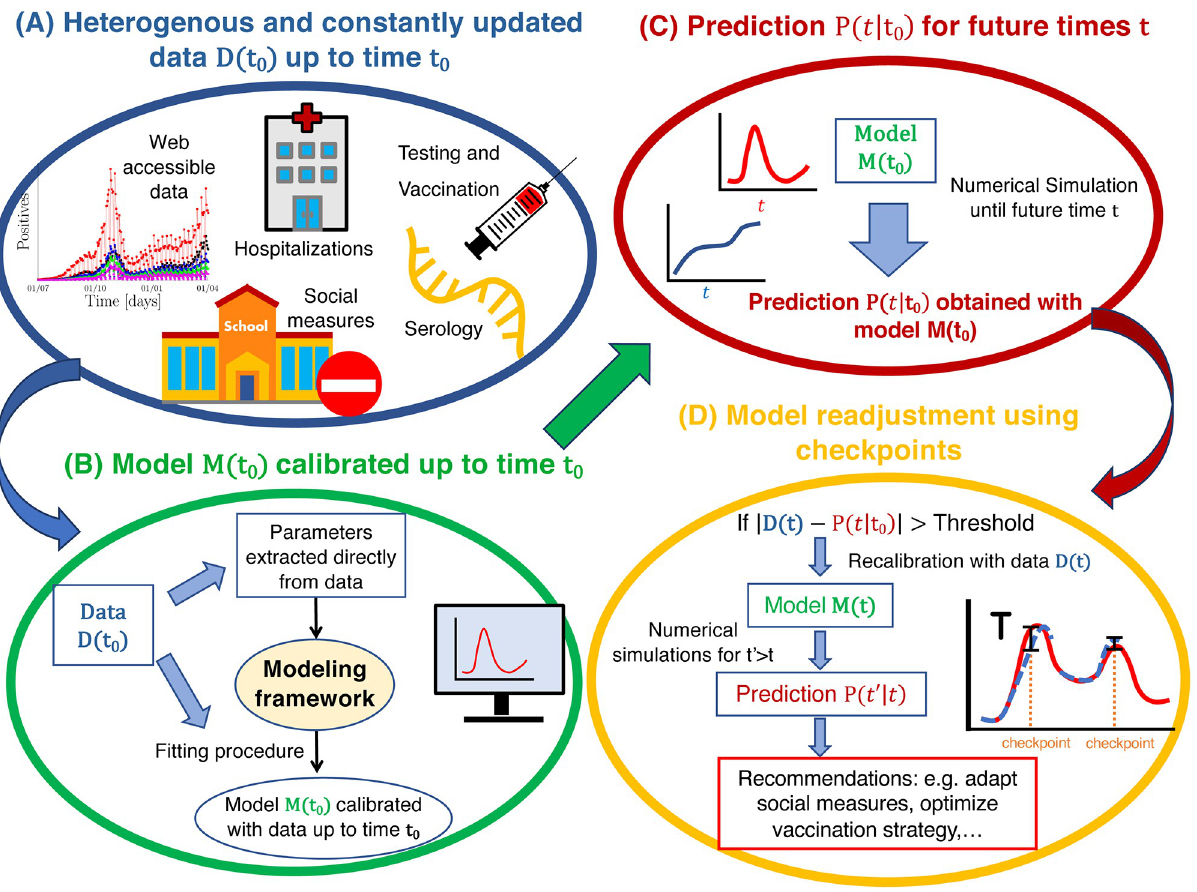
Fig 2. Automated data-driven checkpoint procedure to control a pandemic evolution. (A) A variety of constantly updated data is used to calibrate the model. (B) The model M ( t 0 ) is calibrated with data D ( t 0 ) up to time t 0 . (C) The calibrated model M ( t 0 ) is used to predict the pandemic and hospitalisation situation P ( t | t 0 ) at future times t > t 0 . (D) As time progresses, a checkpoint procedure constantly confronts the predictions P ( t | t 0 ) to the data D ( t ). If at some time t the discrepancy between model and data becomes larger than a threshold T , a recalibrated model M ( t ) is derived using the data D ( t ). The model M ( t ) is then used to generate new predictions P ( t 0 | t ) for times t 0 > t . Based on these predictions, social measures and strategies are adjusted.